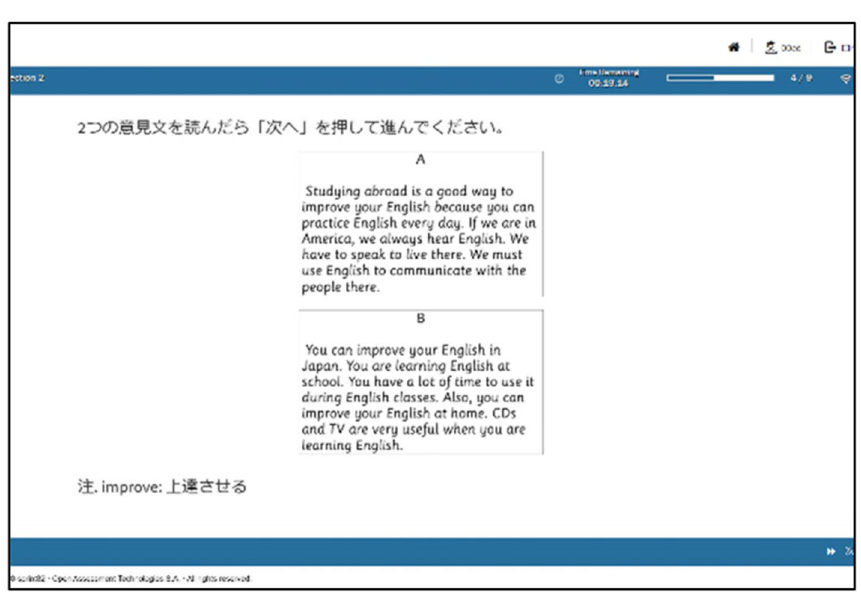
Fig. 3 Screen 2: Reading two types of source texts